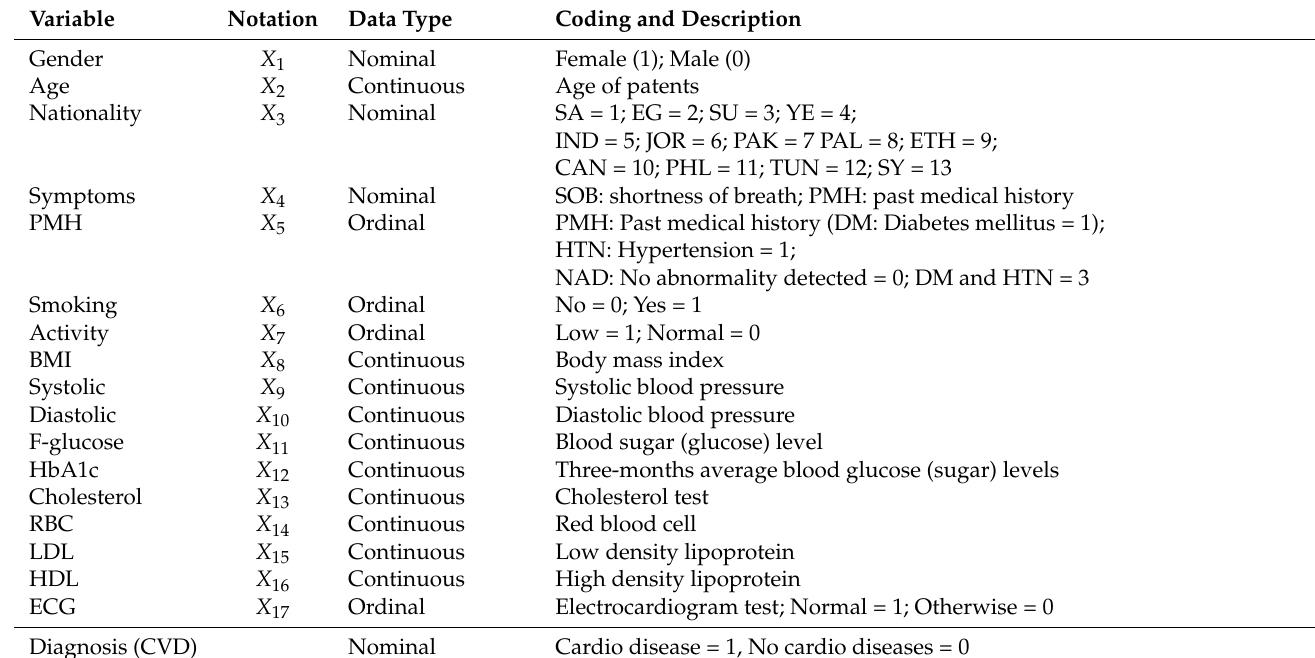
Table 1. The dataset characteristics and descriptions of variables; see abbreviations in Nomenclature.